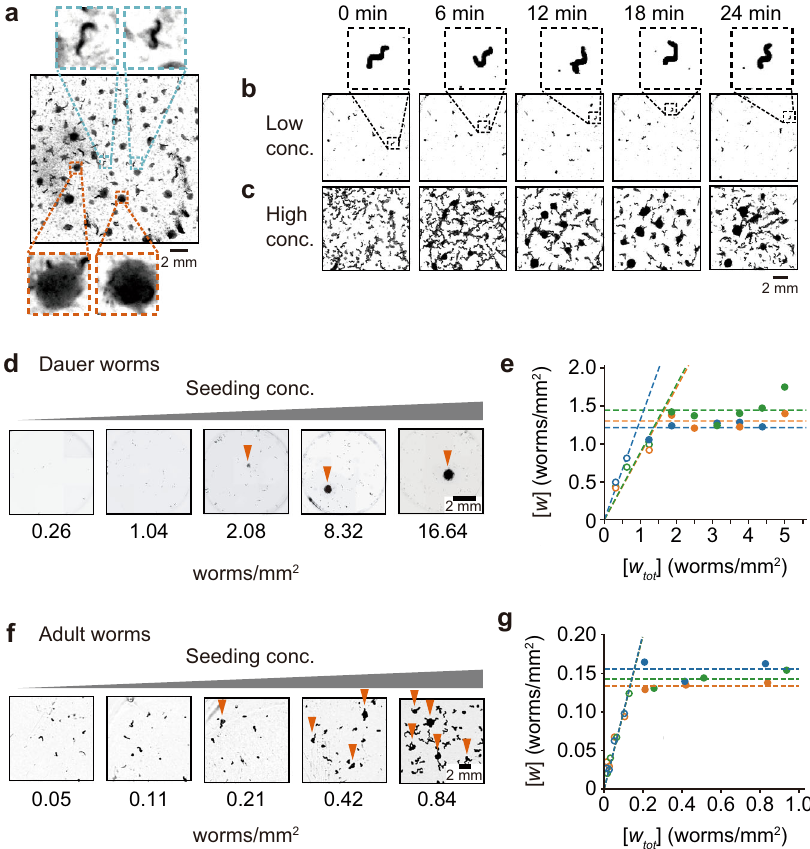
Fig. 1 C. elegans form colonies at high density in the absence of bacteria. a N2 C. elegans formed colonies on an NG plate upon consumption of bacteria. Inserts: blue: dispersed worms; orange: colonies. b , c Washed adult N2 C. elegans seeded at a low concentration (0.02 worms/mm 2 ) ( b ) did not form stable colonies on an agarose plate (Inserts show individual worms), but those seeded at high density (0.18 worms/mm 2 ) ( c ) did. d , f Dauer-stage worms were seeded on agarose pads ( d ) or adults on agarose plates ( f ) at various densities and the systems were allowed to equilibrate for 30 min. Colonies appeared on pads with higher seeding density (arrows) but not with lower. e, g Measured densities of dispersed dauer worms ( e ) or adult worms ( g ) as a function of seeding density. Worms were seeded at various densities on agarose plates and the systems were allowed to equilibrate for 30 min. Plates where colonies formed are indicated with fi lled circles, and plates with no colonies with open circles. Data are from three independent experiments for either dauer ( e ) or adult worms ( g